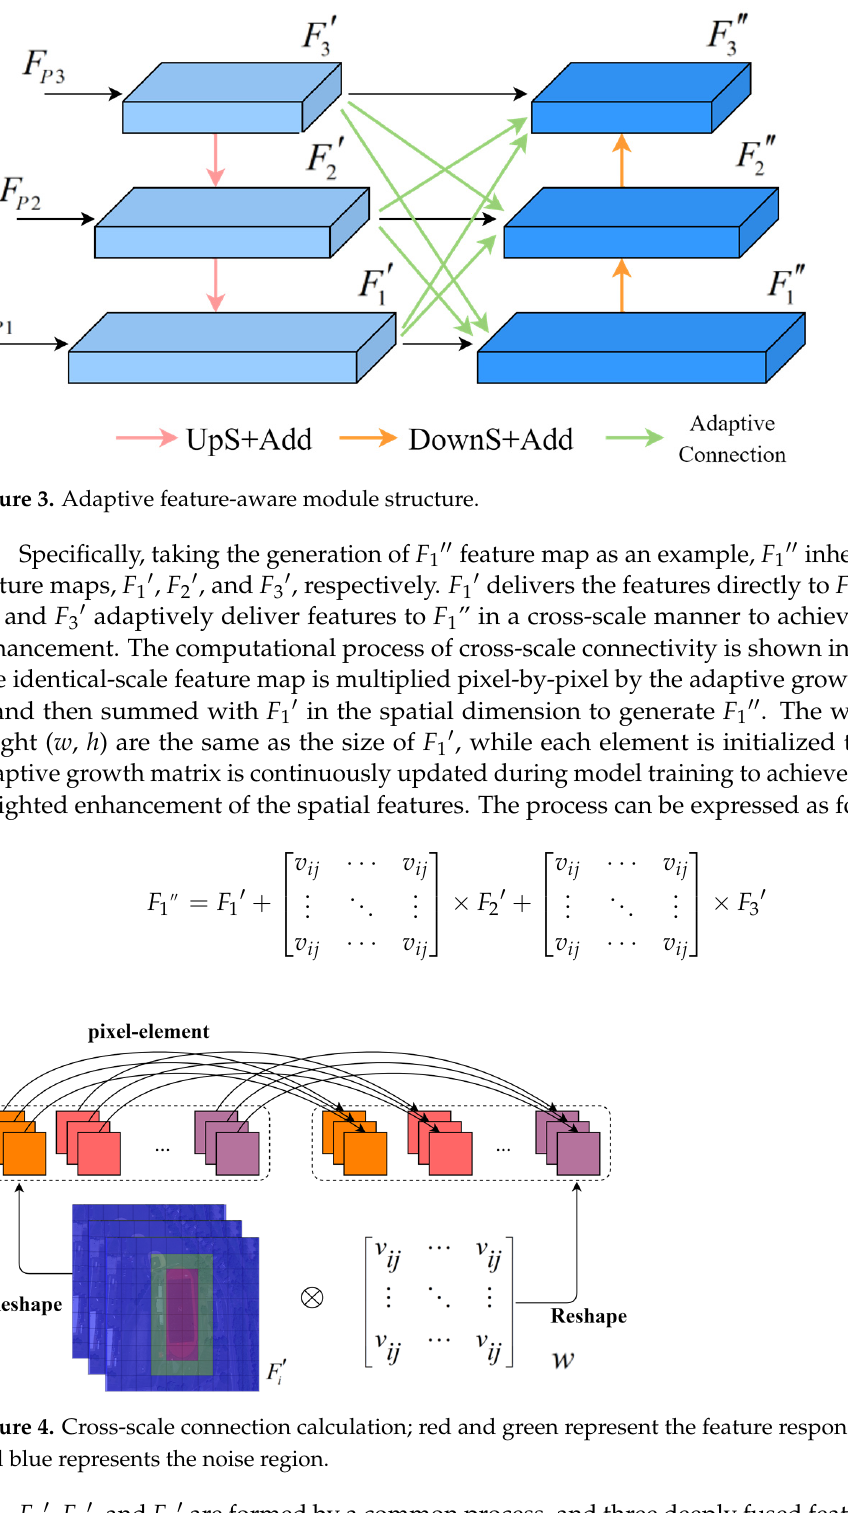
Figure 4. Cross-scale connection calculation; red and green represent the feature response regions and blue represents the noise region. and blue represents the noise